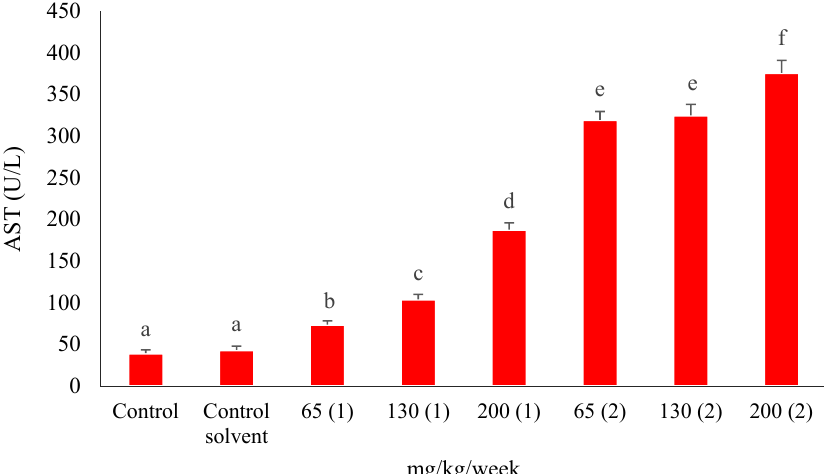
Fig. 6: Means ± SD of the levels of aspartate aminotransferase (AST) (unit/L) in the Caspian kutum exposed to fipronil for 7 (1) and 14 (2) days